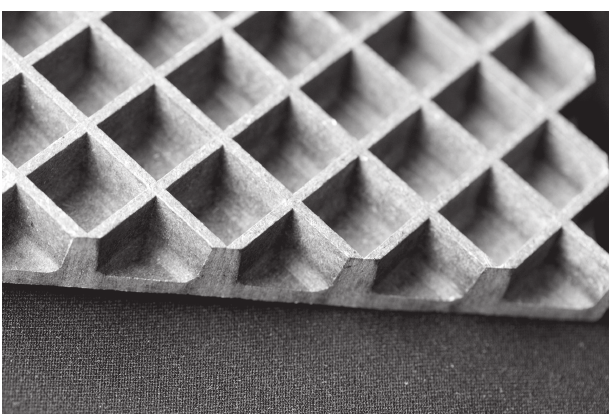
Figure 4. Photograph of a complex shape of an 85% kenaf-PP/MAPP board. The total depth of the board was about 1.4 cm and the grid height was 1 cm showing how complex shapes can be molded directly after the blending cycle.